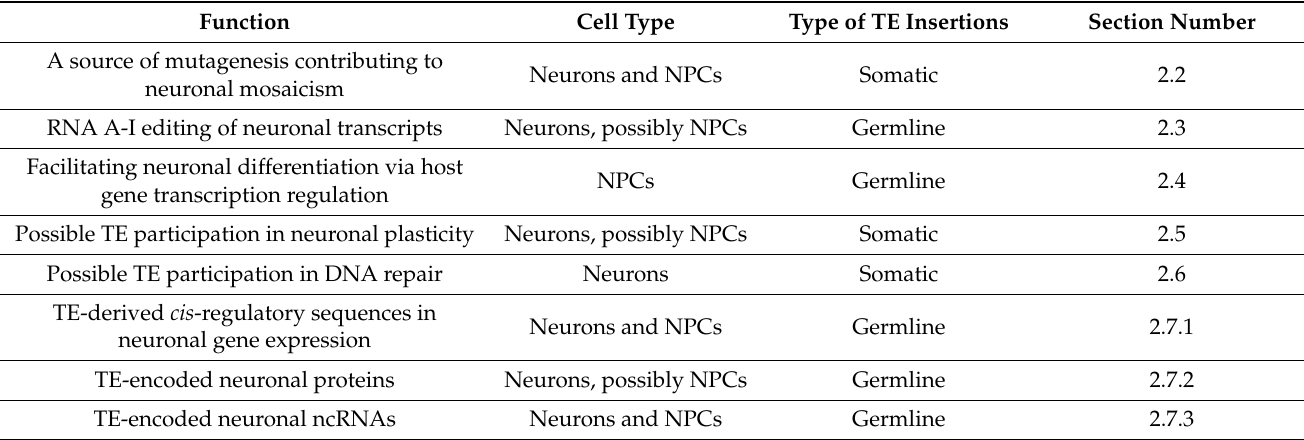
Table 2. Functions of exapted TEs in neuronal